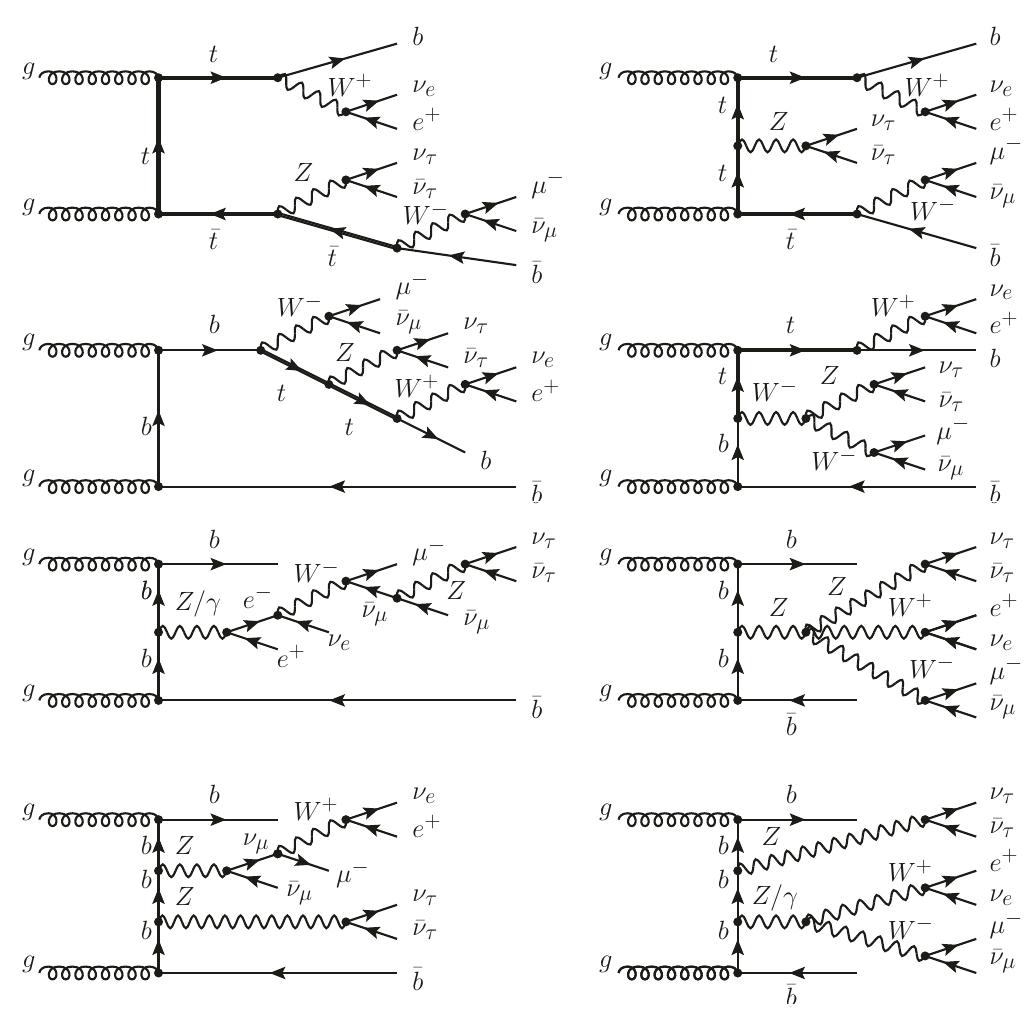
Figure 2 . Representative Feynman diagrams with double- ((cid:12)rst row), single- (second row) and no top quark resonances (third row) contributing to pp e + (cid:23) e (cid:22) (cid:0) (cid:22) (cid:23) (cid:22) b (cid:22) b(cid:23) (cid:28) (cid:22) (cid:23) (cid:28) production at the leading ! order in perturbative expansion. Diagrams with a single W boson resonance that contribute to the o(cid:11)-shell e(cid:11)ects of the W gauge boson are also presented (last